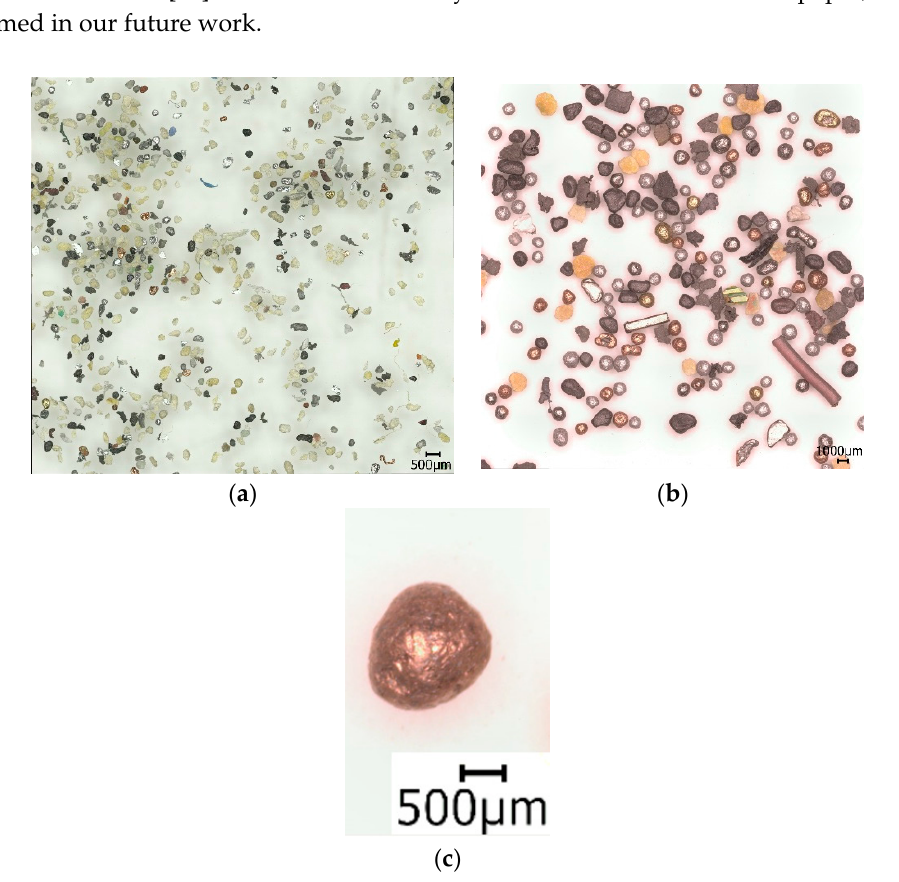
Figure 5. Digital microscopic images of ( a ) a product ( − 0.125 mm) under selective size reduction (20 g feed mass, 90 s milling time) condition from 1–2 mm feed, ( b ) a product (1–2 mm) under selective agglomeration (80 g feed mass, 90 s milling time) condition from 1–2 mm feed, and ( c ) Cu agglomerate formed in the product size 1–2 mm during the hammer milling operation under 80 g feed mass and 90 s milling time.